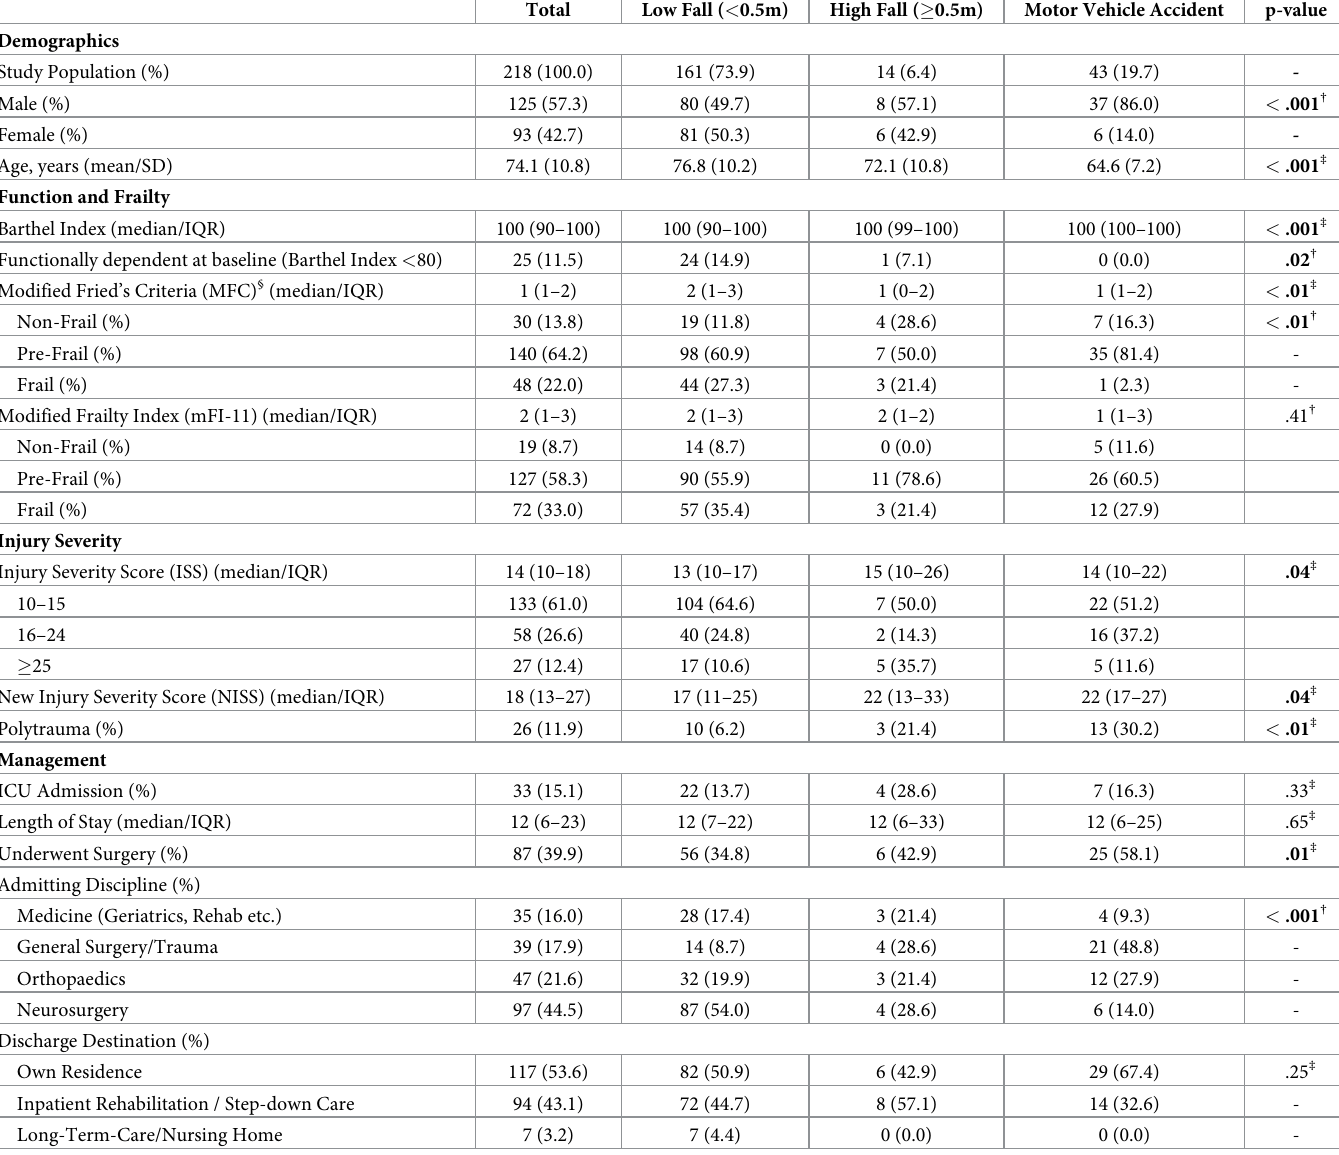
Table 1. Demographics, frailty, injury severity and discharge destination by mechanism of